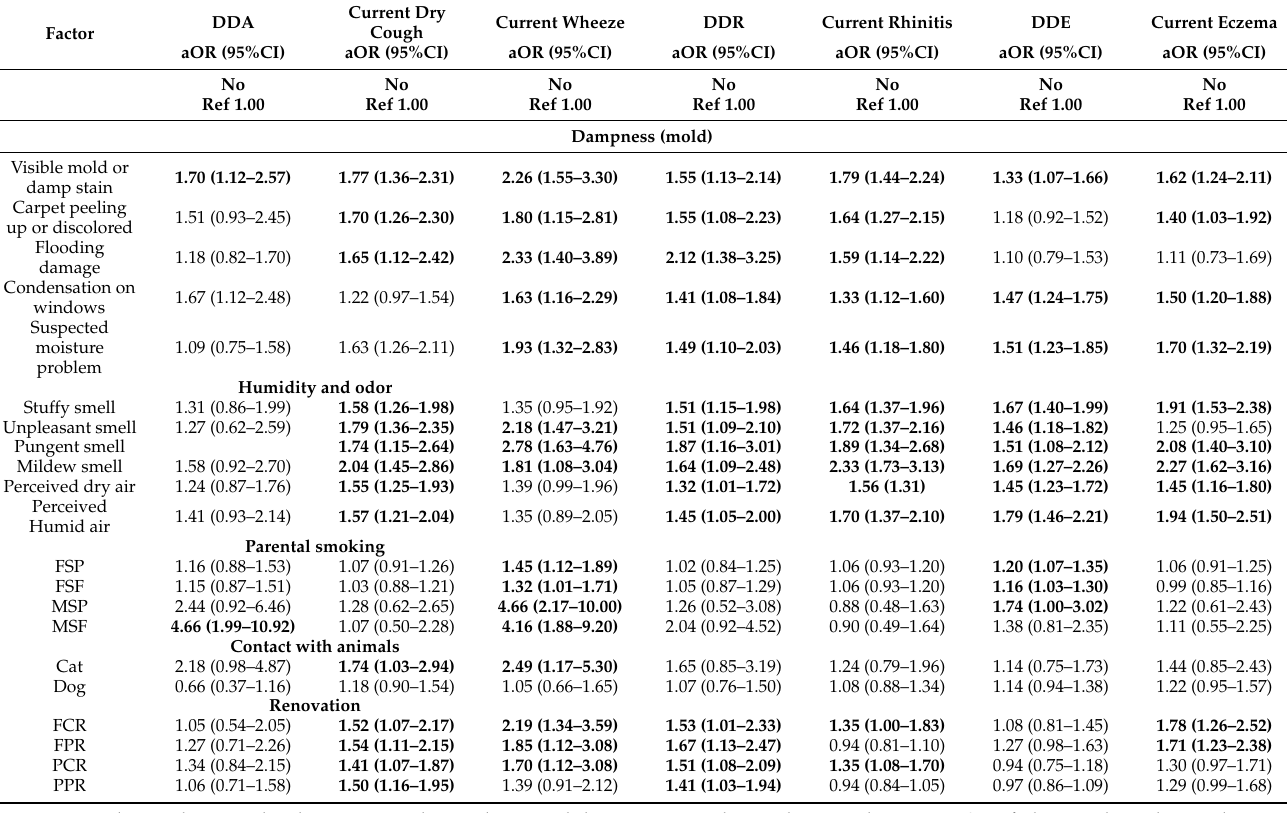
Table 4. Associations between perinatal factors and children’s allergic diseases using binary logistic regression with